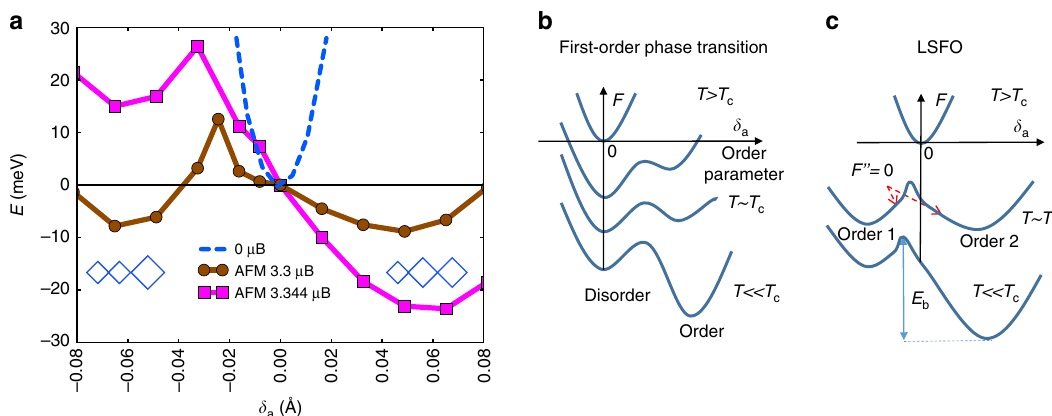
Fig. 4 Results of DFT + U calculations. a The total energy curve calculated using DFT + U as a function of the Fe – O bond length difference δ a (see inset Fig. 1b) along [111] axis at various Bohr magnetons ( μ B ). The curves with 3.3 and 3.344 μ B was obtained by U = 3.7 eV and 3.8 eV in DFT + U while fi xing the U / J ratio. The arrays of blue diamonds represent the ordering of the small and large oxygen octahedrons around δ a = ± 0.06 Å. b The schematic energy potential surfaces for the typical fi rst-order phase transition at various temperatures. c The energy potential surface for LSFO shows the degenerate charge ordered states (order 1 and order 2) around the transition temperature. E b is the energy barrier between two competing charge-ordered states. F '' is the second derivative of total